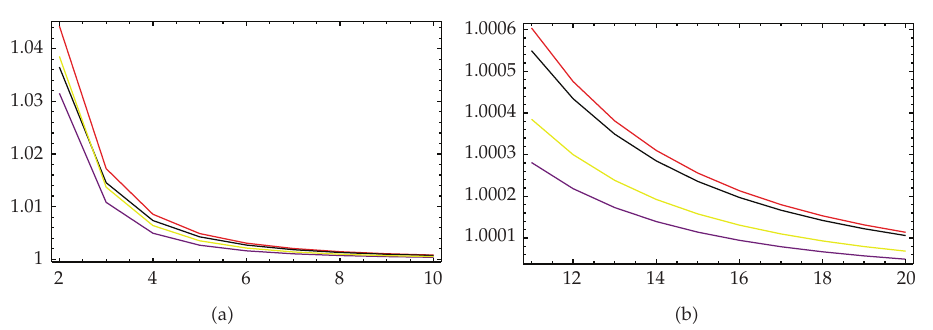
Figure 2: The plot of the flops-like e ffi ciency indices for di ff erent methods (cid:2)(cid:2) a (cid:3) , for n (cid:4) 2 ,..., 10 and (cid:2) b (cid:3) , for n (cid:4) 11 ,..., 20 (cid:3) .